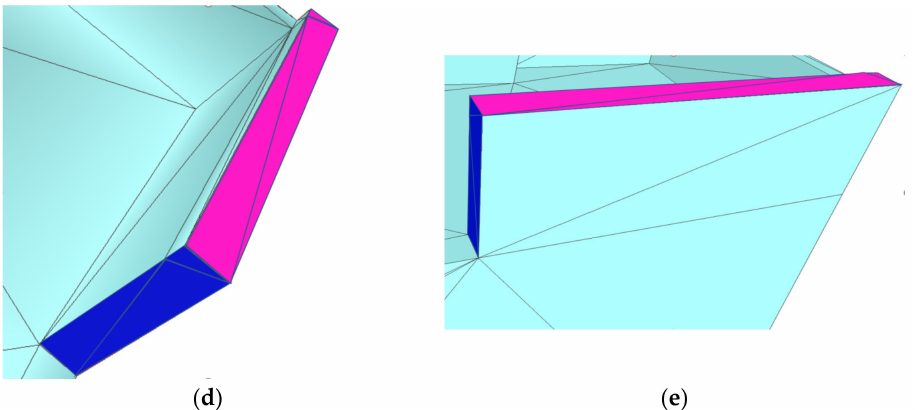
Figure 7. Connection plane rebuilding example. ( a ) is the top view of the initial segmentation result, and inside the green circle is the parapet formed by the directed connection of two parallel planes; ( b ) is the side view of ( a ); ( c ) is the result of topology modification, the white circle is the horizontal connection plane (corresponding to the pink faces in ( d , e )), and the gold circle is the vertical connection plane (corresponding to the blue faces in ( d , e )); ( d , e ) are the close-ups of the parapet of the simplified model in the top and side view,